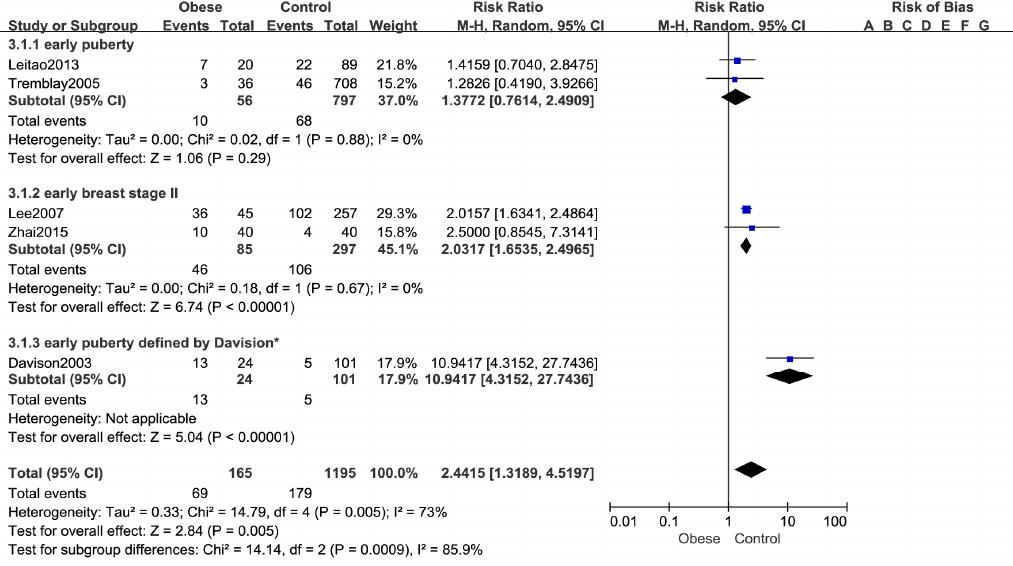
Figure 4. Forest plot for number of girls with early puberty between the obese group and control